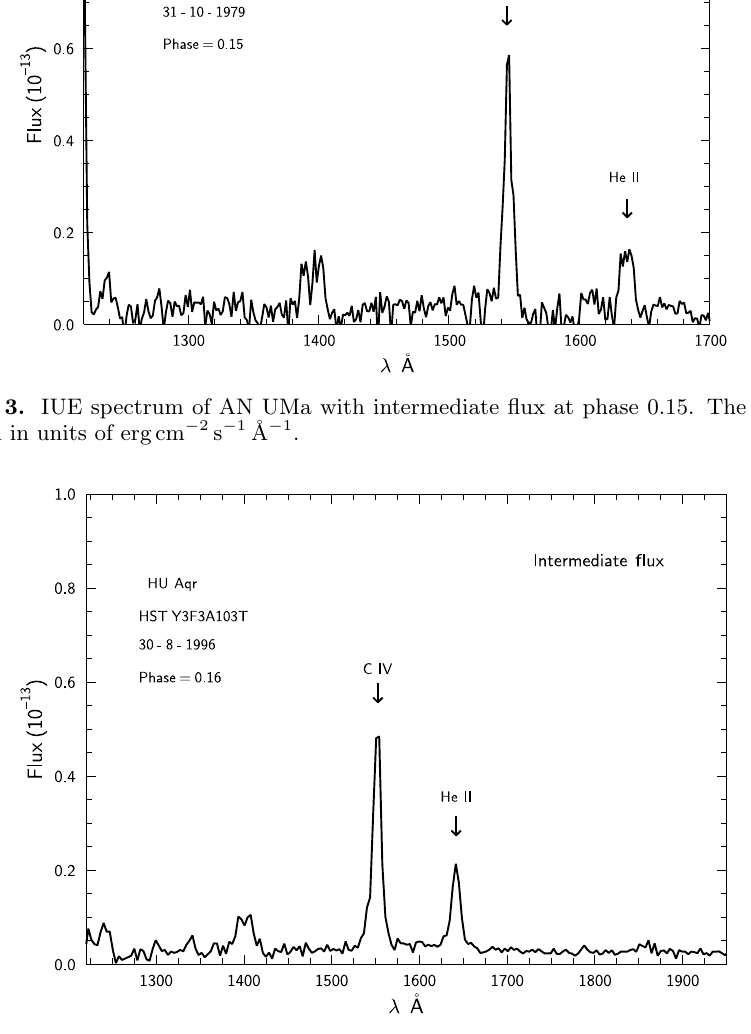
Fig. 4. IUE spectrum of HU Aqr with intermediate (cid:13)ux at phase 0.16. The (cid:13)ux is plotted in units of erg cm (cid:0) 2 s (cid:0) 1 (cid:23)A (cid:0) 1 . the G140L grating and 52 (cid:2) 0.2 aperture. The details of these observations are listed in Tables 3 and 4. Representative examples of emission lines are given in Figs. 4, 5 and 6, showing the variations in line fluxes at different times. For both star systems these lines are produced in the accretion